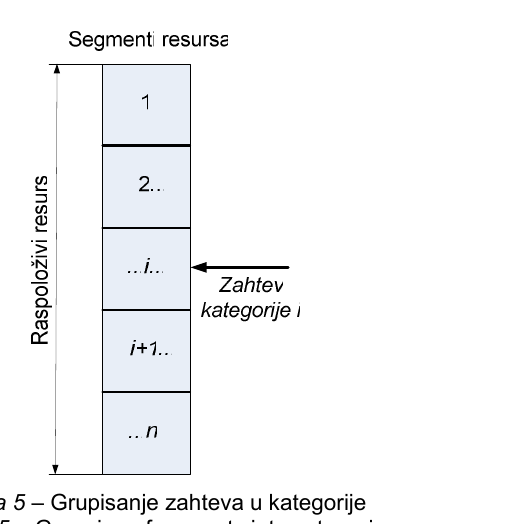
Figure 5 – Grouping of requests into